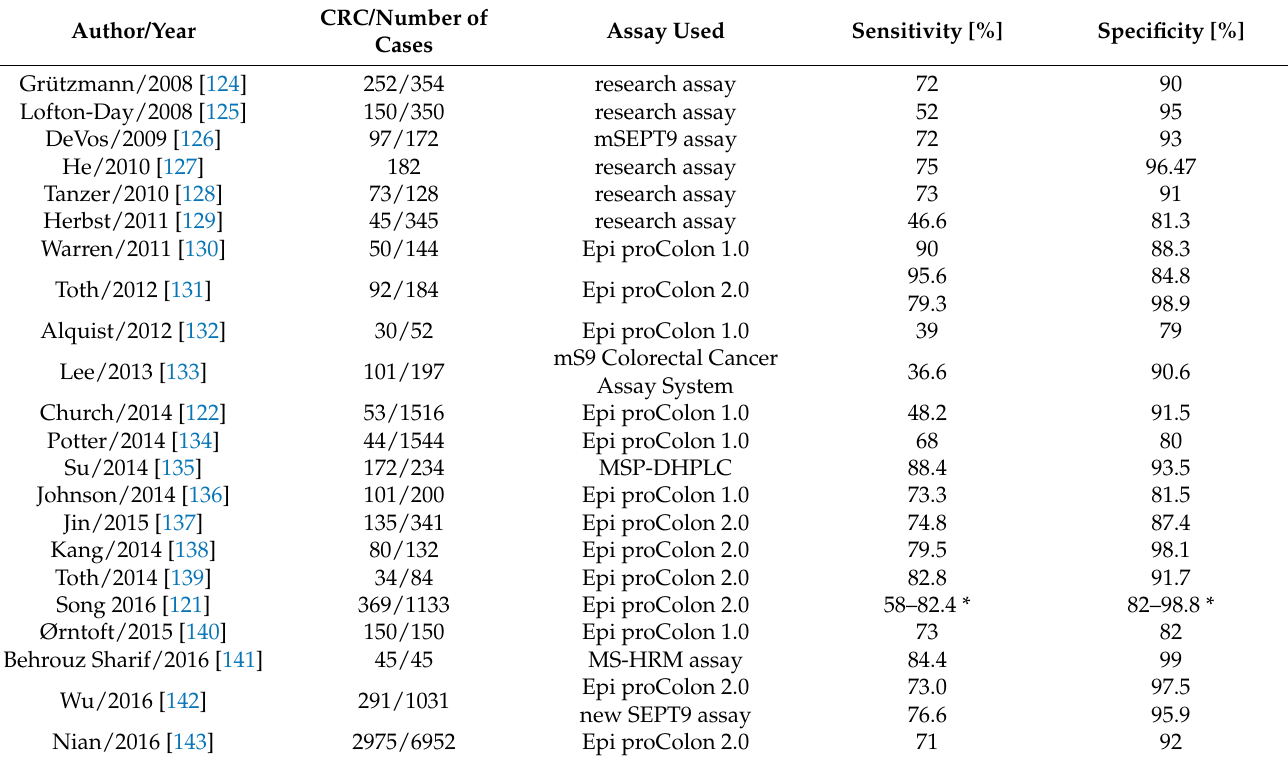
Table 4. Sensitivity and specificity of the SEPT9 gene methylation assay for colorectal cancer